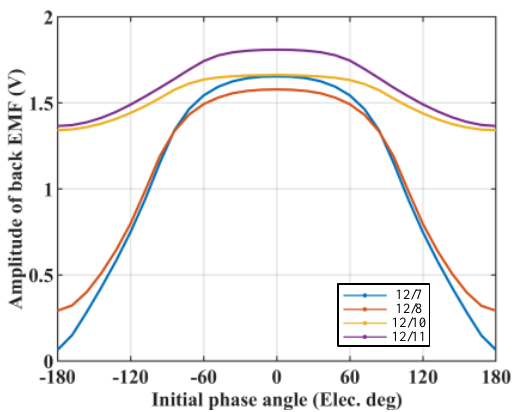
Figure 13. The curves of back EMF amplitude vs. the initial phase angle.